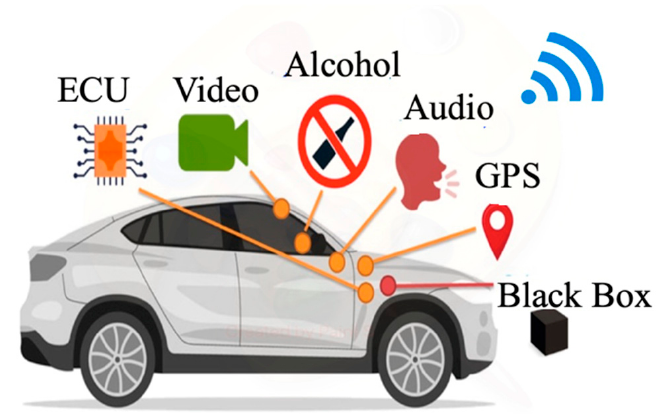
Figure 1. The car’s black box system with the input signals.